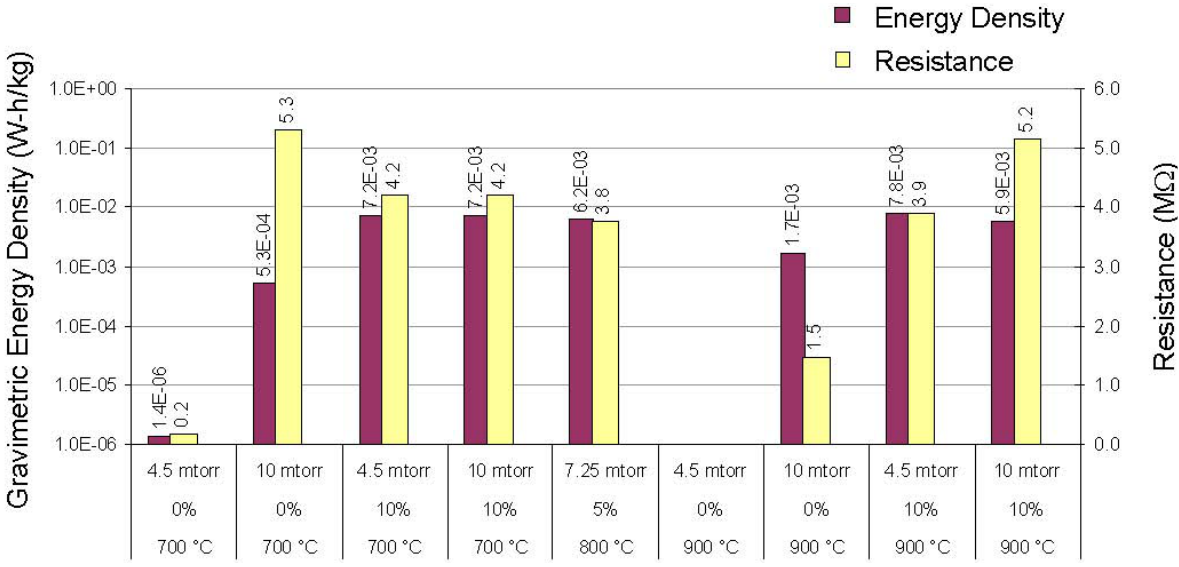
Figure 7. Specific energy and internal resistance of thin-film capacitors vs . dielectric deposition